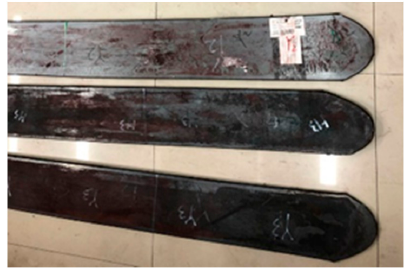
Figure 1. The shape of the rolled products.